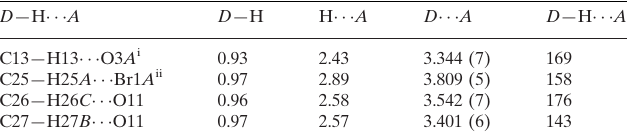
Hydrogen-bond geometry (A˚ , (cid:2)